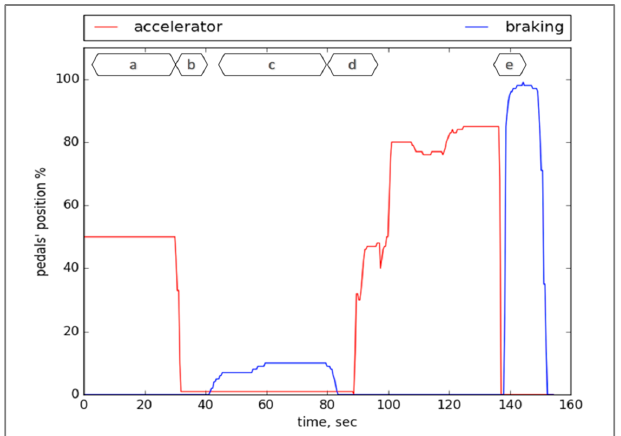
Figure 1. Typical dynamics of accelerator- and brake pedals during ( a ) cruising, ( b ) slowing down (e.g., approaching corner), ( c ) normal braking (e.g., approaching a stop sign), ( d ) accelerating, and ( e ) emergency braking, respectively.